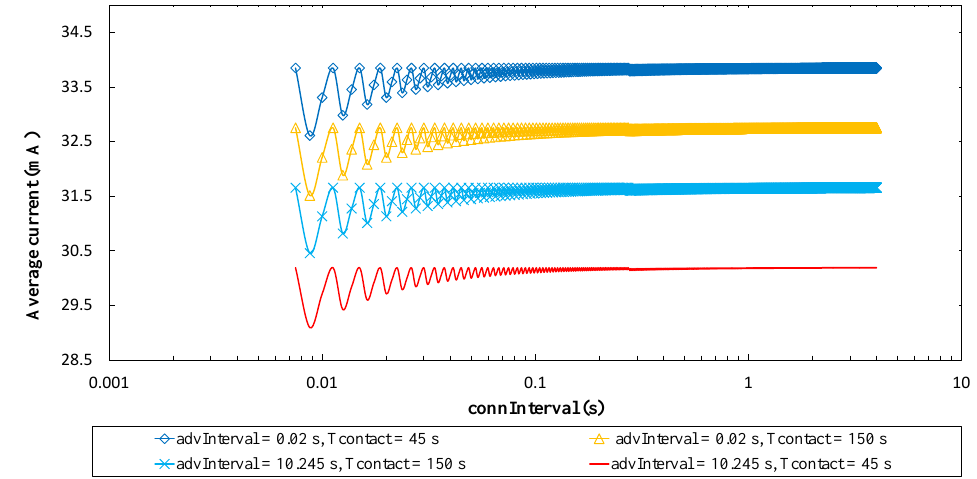
Figure 12. Average current consumption of the sensor node within a T conn period in the connection-based approach, as a function of connInterval , and for N = 3 and BER = 0.